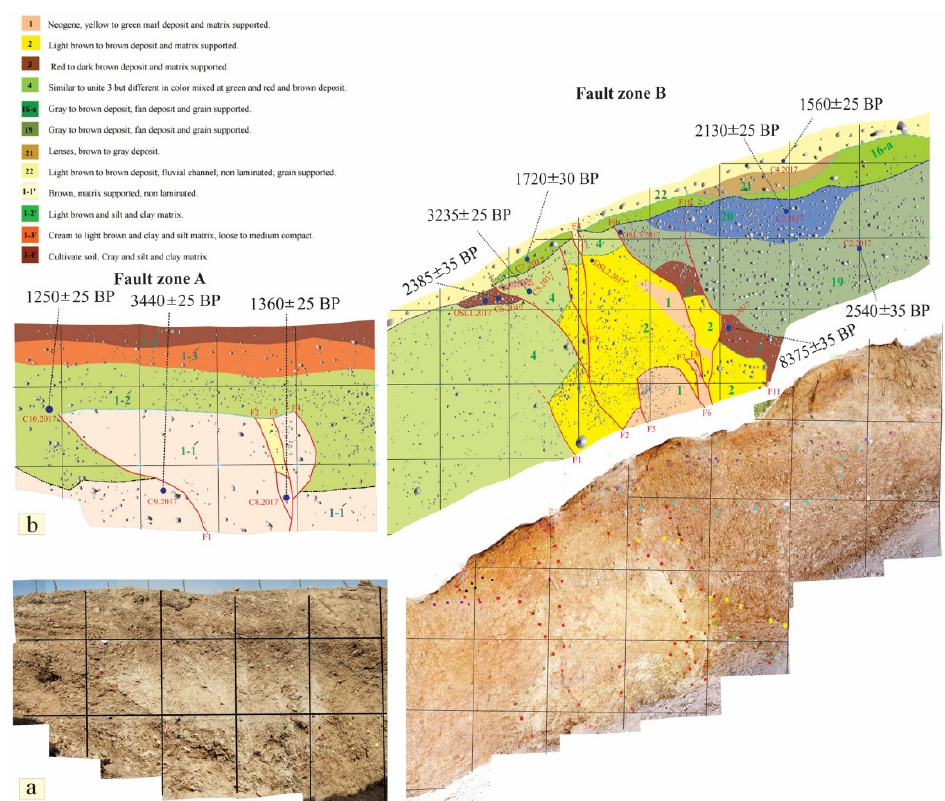
Figure 12. Interpretive sketch and ( a ) a general orthophoto mosaic of the west and east walls, originally rendered at 1 mm resolution; ( b ) a detailed paleoseismic log of the wall of fault zone A and B.